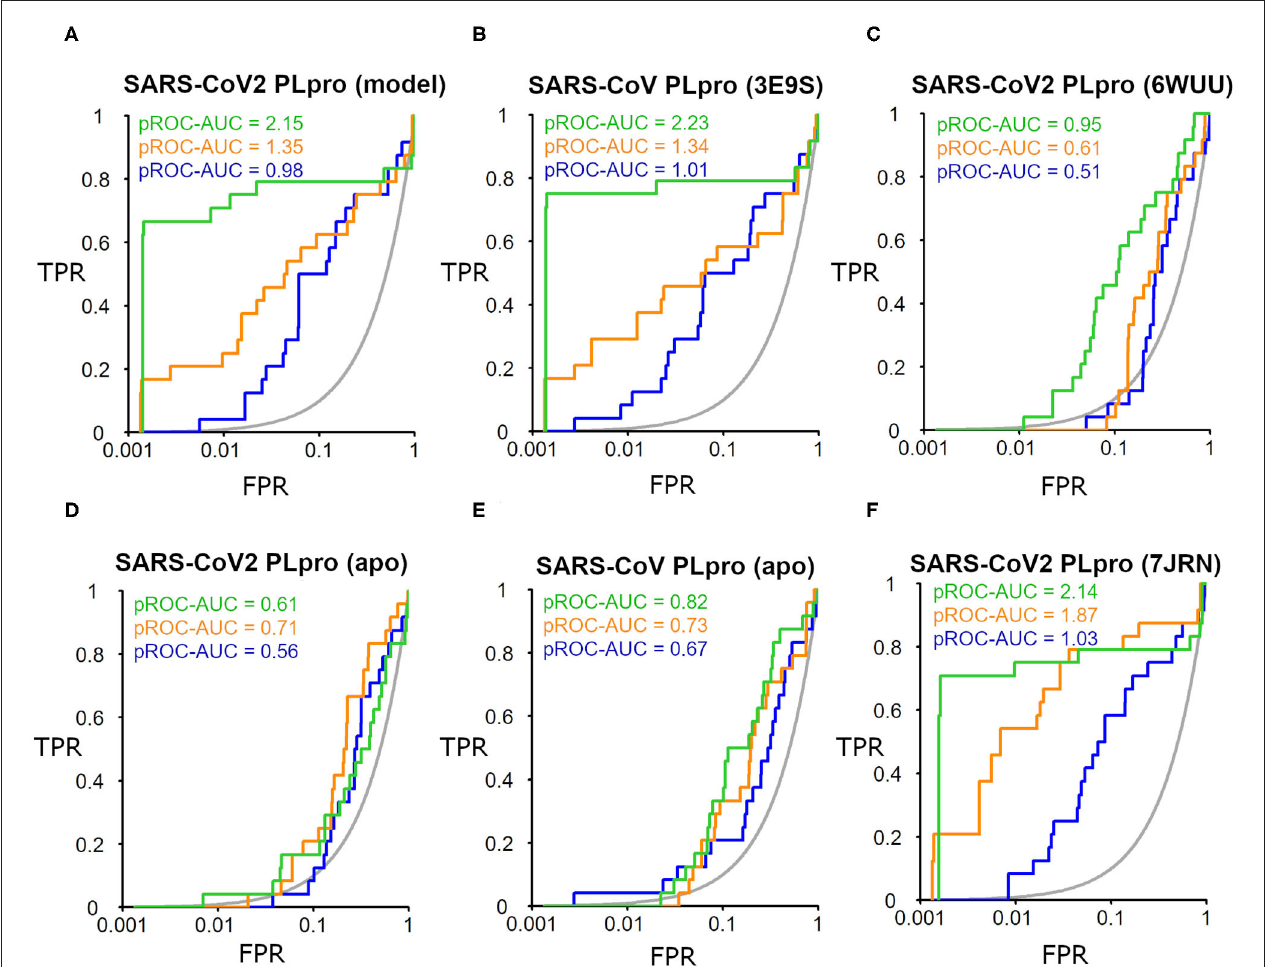
FIGURE 6 | pROC plots of docking experiments showing the screening performance of both ligand-bound conformations of the SARS-CoV-2 PLpro model, the co-crystal structure of SARS-CoV PLpro (PDB ID: 3E9S), and the co-crystal structure SARS-CoV2 PLpro (PDB ID: 6WUU) as (A–C) , respectively. (D,E) are for the screening performance of both apo structures of SARS-CoV-2 PLpro (PDB ID: 6W9C) and of SARS-CoV PLpro (PDB ID: 2FE8), respectively. (F) The screening performance of the recently introduced X-ray SARS-CoV-2 PLpro complexed with TTT (PDB ID: 7JRN). The graphs of the docking tools FRED, AutoDock Vina, and PLANTS screening results are shown in green, orange, and blue, respectively. The true positive rate (TPR) is the fraction of recovered bioactives; the false-positive rate (FPR) is the fraction of recovered decoys from a score-ordered list of all decoys. The gray line corresponds to a random screening